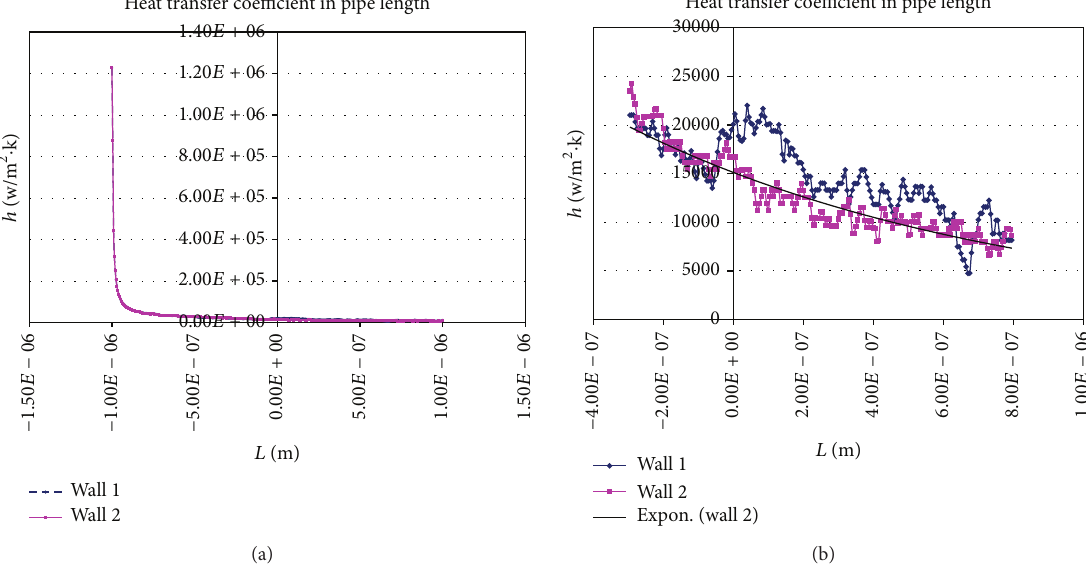
Figure 6: Case 2, convective heat transfer coefficient on walls 1 and